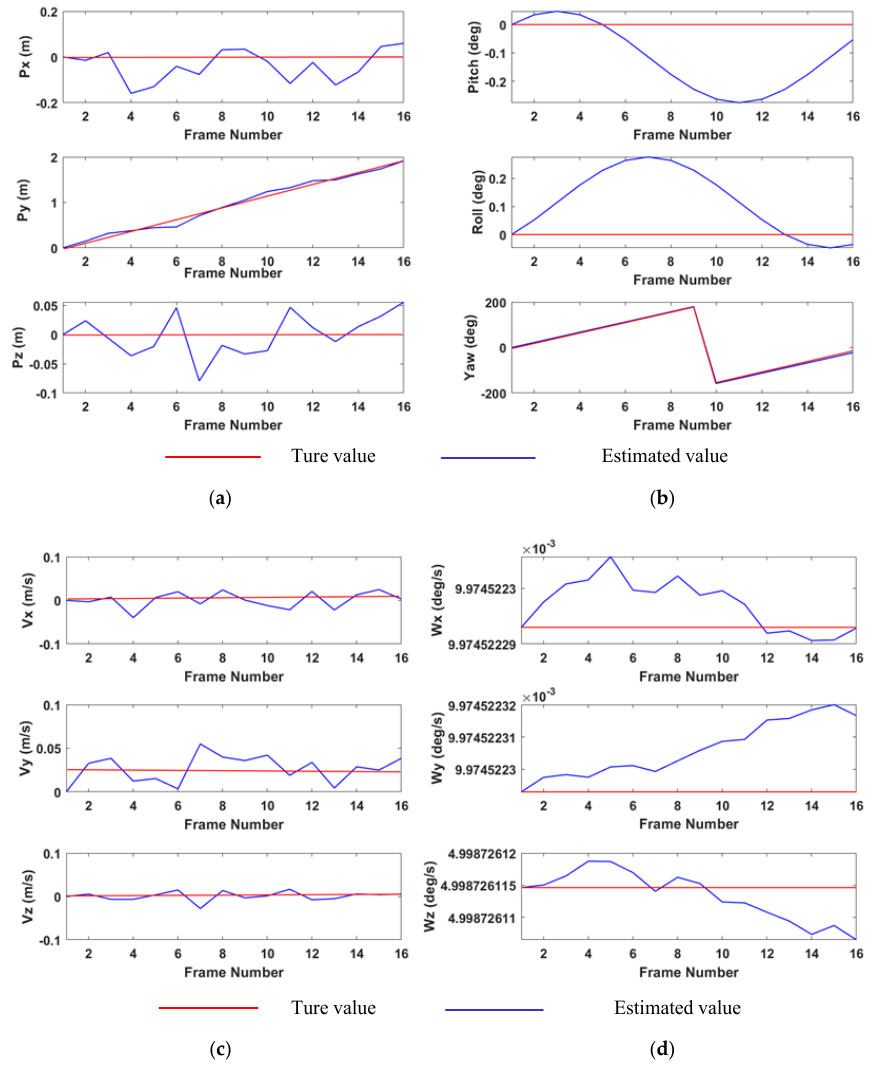
Figure 8. ( a ) Translational position, ( b ) angular position, ( c ) velocity, and ( d ) angular velocity estimation results of the target spacecraft.